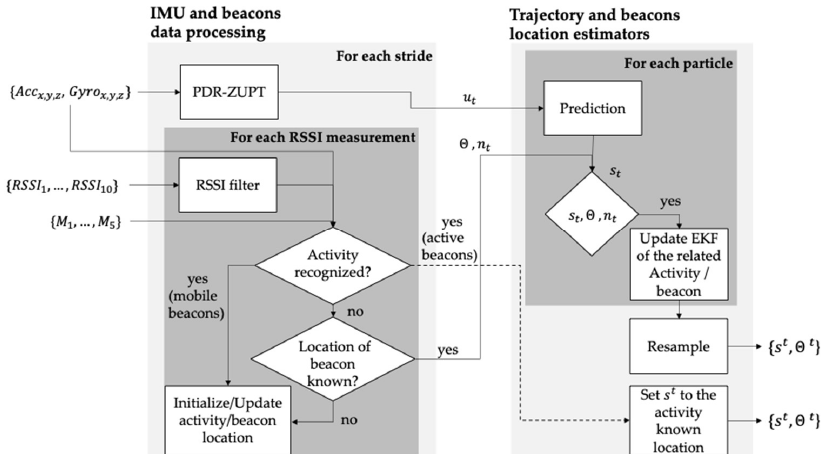
Figure 4. Proposed framework. The left block receives IMU and beacons data, executes a pedestrian dead-reckoning algorithm, initializes the beacon’s location, and recognizes the human activities. The block on the left implements the three phases of a particle filter algorithm: prediction, update, and resample. As a result, the person and beacon’s indoor location are obtained.